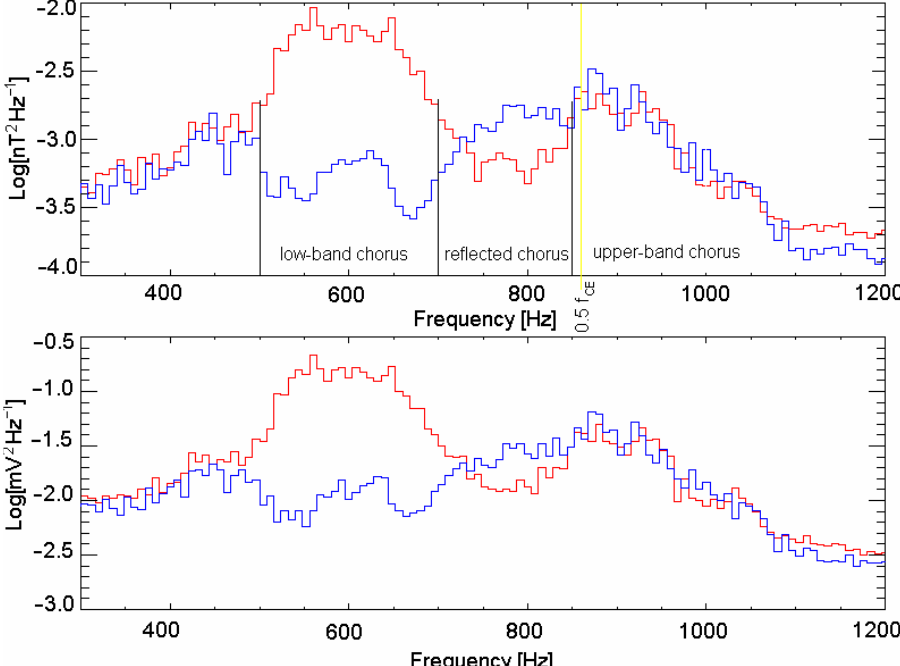
Fig. 5. Magnetic and electric field fluctuation spectra (THA SCW and EFI measurements). Red and blue correspond to times when forward and reflected chorus elements were registered. The estimation of reflected chorus energy gave it nearly 0.01 of the forward chorus energy.